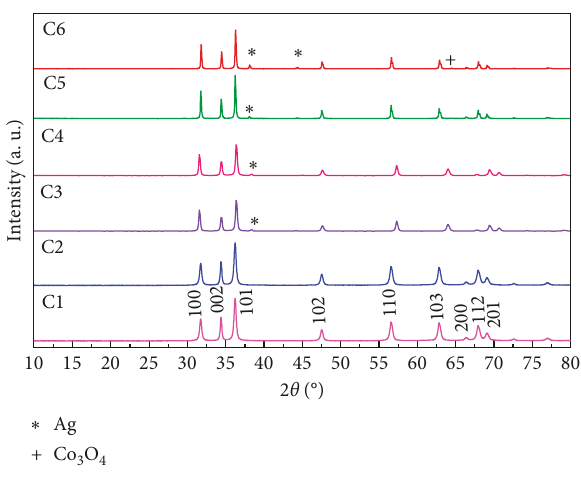
Figure 2: XRD patterns of Zn